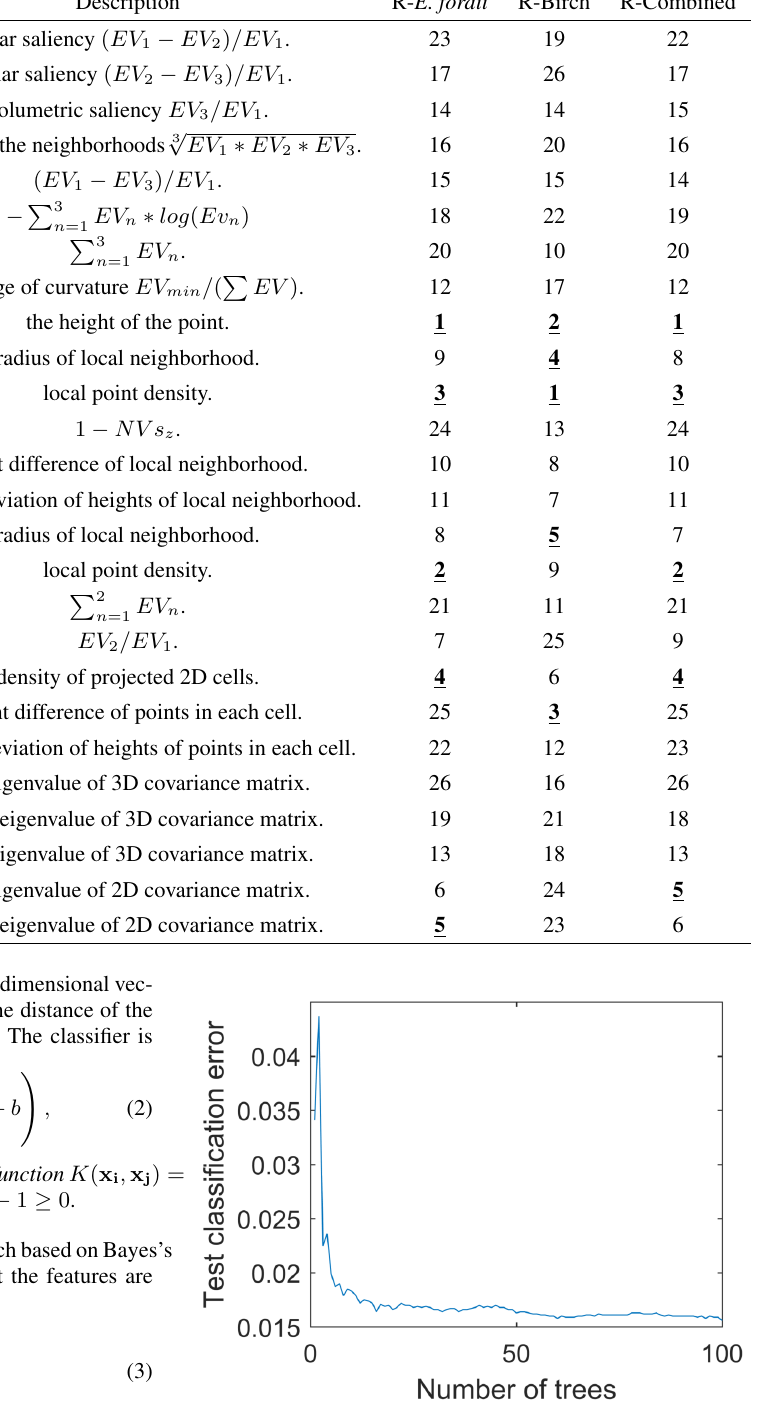
Figure 3. Evaluation of number of classification trees to be